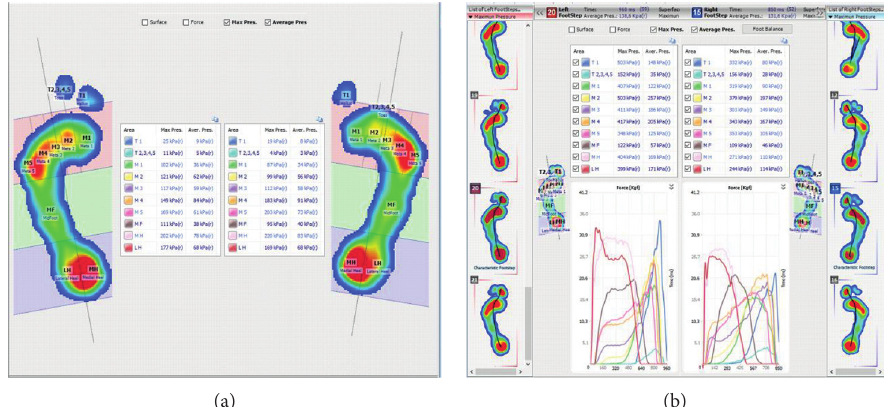
Figure 10: (a) The result of pedobarographic test when standing. (b) While walking, patient no. 10, increased pressure on the M1-M5